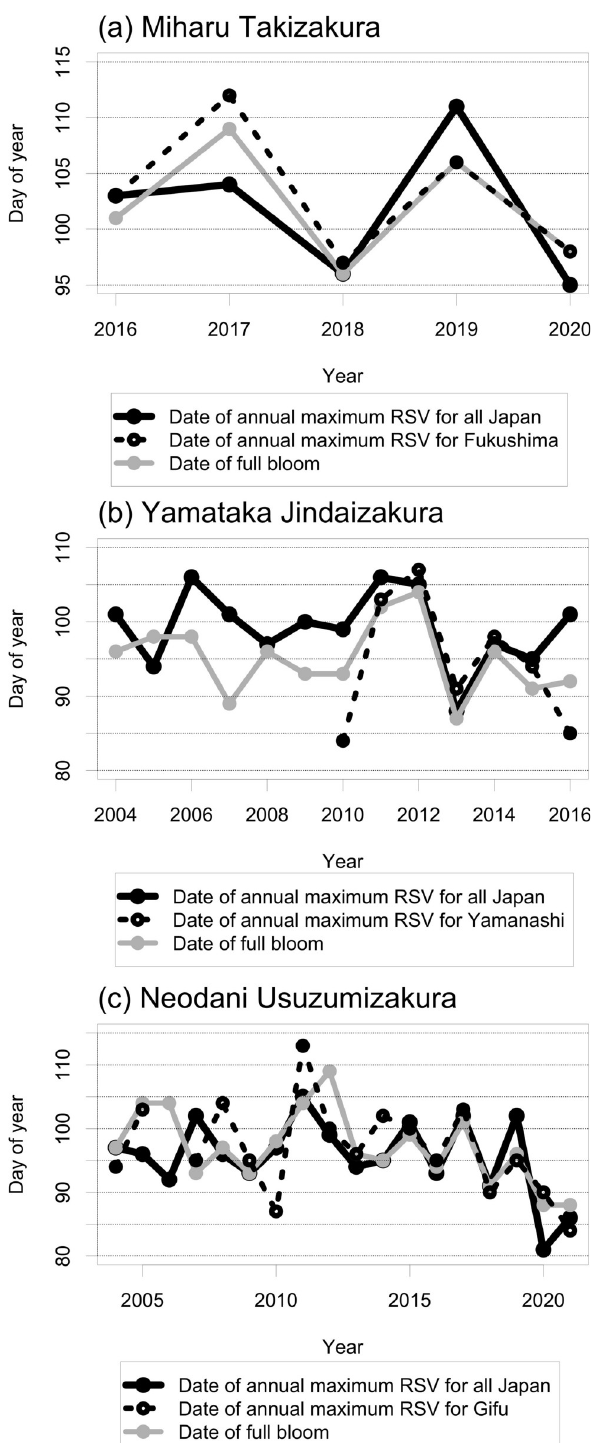
Fig 6. For each indicated tree, the relationship between the date of annual maximum RSV (= 100) searched by “Topics” in all Japan and by prefecture and the first date of full bloom based on the flowering information published on websites. For Miharu Takizakura in 2018 in all Japan (day of year [DOY] 96 and 97), Miharu Takizakura in 2020 in Fukushima (DOY 98 and 99), and Neodani Usuzumizakura in 2014 in Gifu (DOY 80 and 102), the dates of annual maximum RSV overlapped; we selected the date closer to the date of full bloom. See statistics in Table 2.